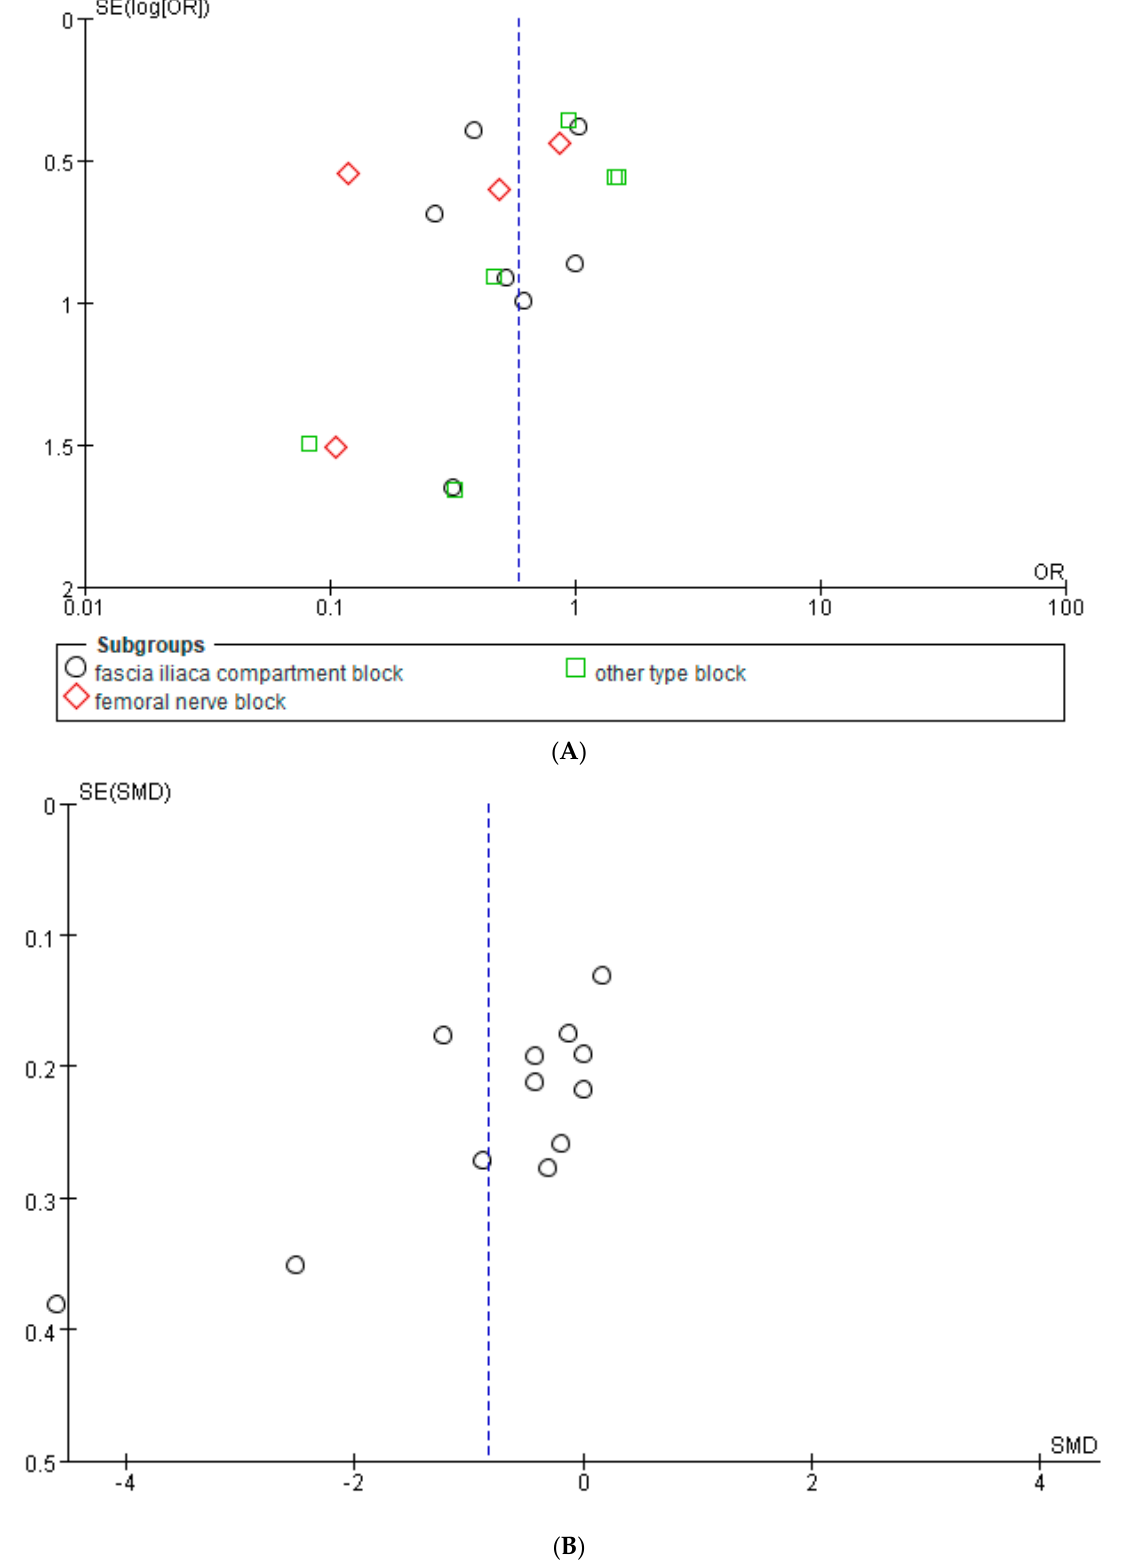
Figure 5. Funnel plot for publication bias. ( A ) Postoperative delirium at postoperative day three. ( B ) Postoperative pain scores. SE, standard error; OR, odds